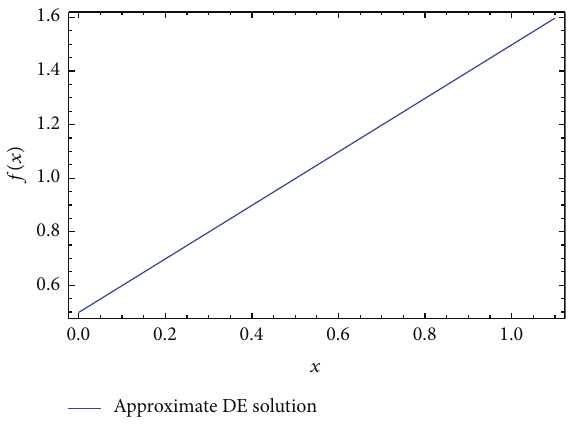
Figure 10: Approximate solution for 1000𝑦 󸀠󸀠 + (1 − 𝑦 2 )𝑦 󸀠 + 𝑦 = 0 with 𝑦(0) = 0.5 and 𝑦 󸀠 (0) = 1 .